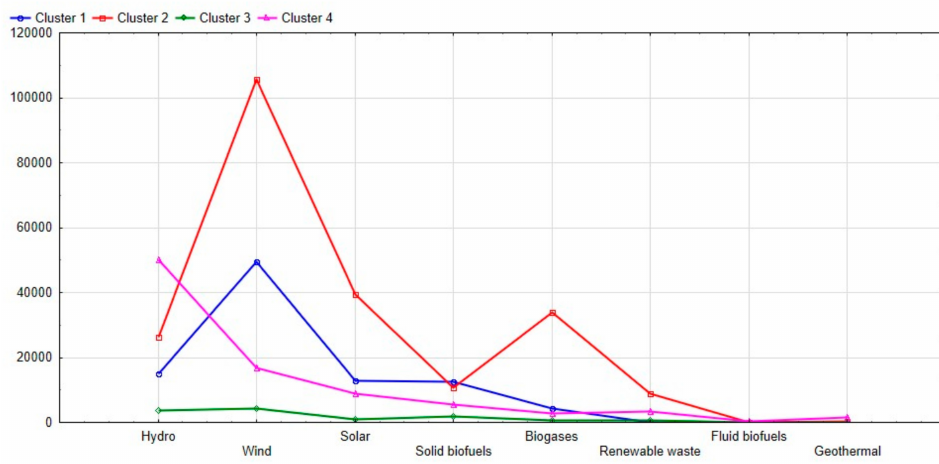
Figure 11. Mean values of energy production from renewable energy sources for individual clusters (own study).